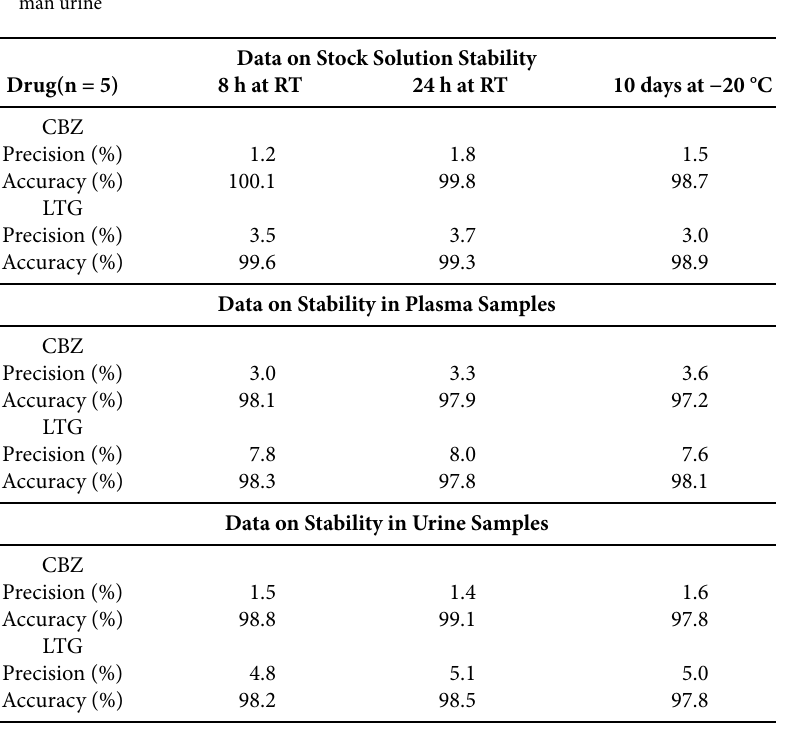
Table 1. Summary of stability of CBZ and LTG in stock solution and human plasma and hu- man